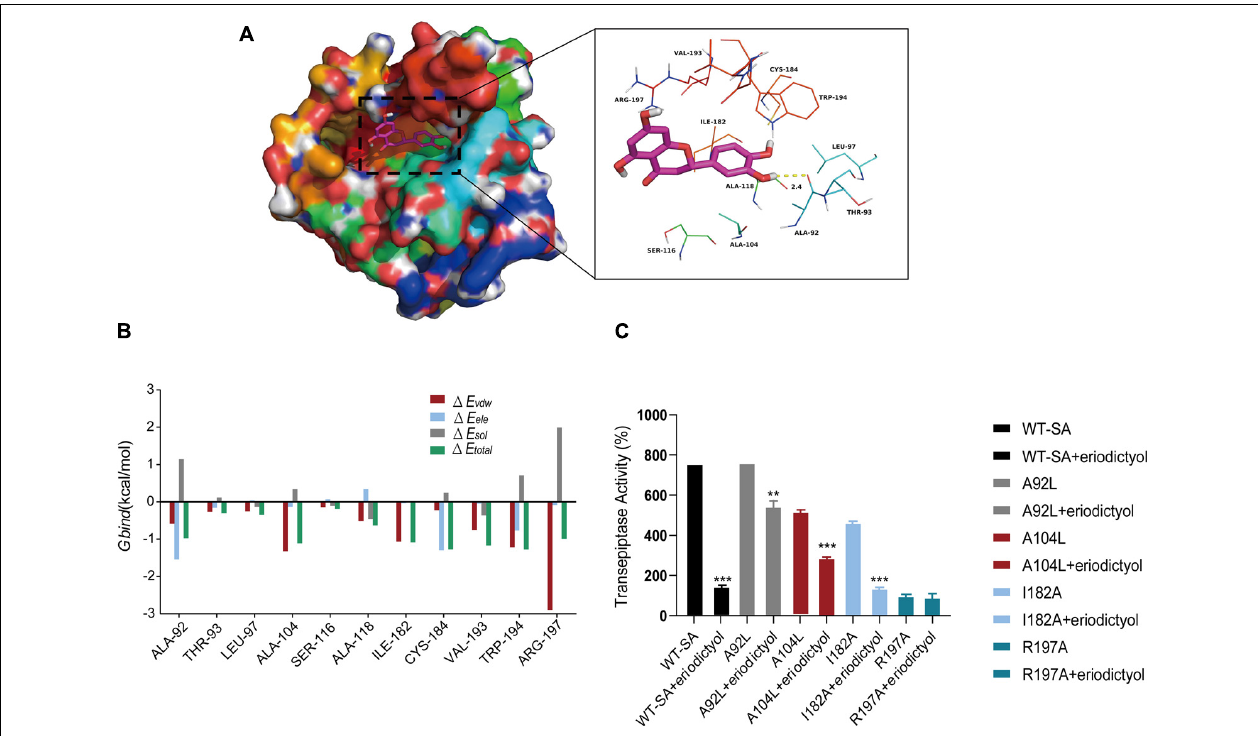
FIGURE 5 | Molecular modeling of the interaction of eriodictyol with SrtA. (A) Decomposition of the free energy on a per-residue basis for the binding of eriodictyol to modeled S. aureus SrtA. (B) Docking model of eriodictyol within SrtA generated by molecular dynamics simulation. (C) WT-SrtA and SrtA mutants (A92L-SrtA, A104-SrtA, I182A-SrtA, and R197A-SrtA) were incubated with 64 µ g/mL eriodictyol, and the transpeptidase activity of recombinant SrtA was determined by FRET. ** P < 0.01, *** P < 0.001 compared with the WT